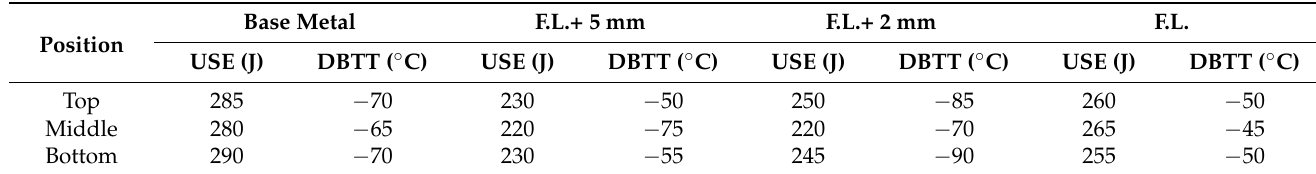
Table 6. USE and DBTT of base metal and HAZ.